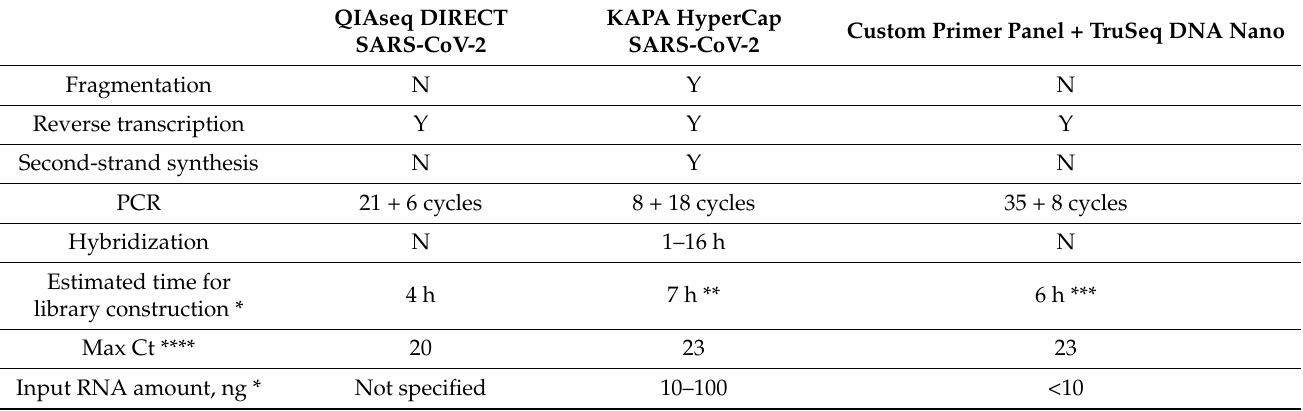
Table 1. Workflow comparison for the different library kits